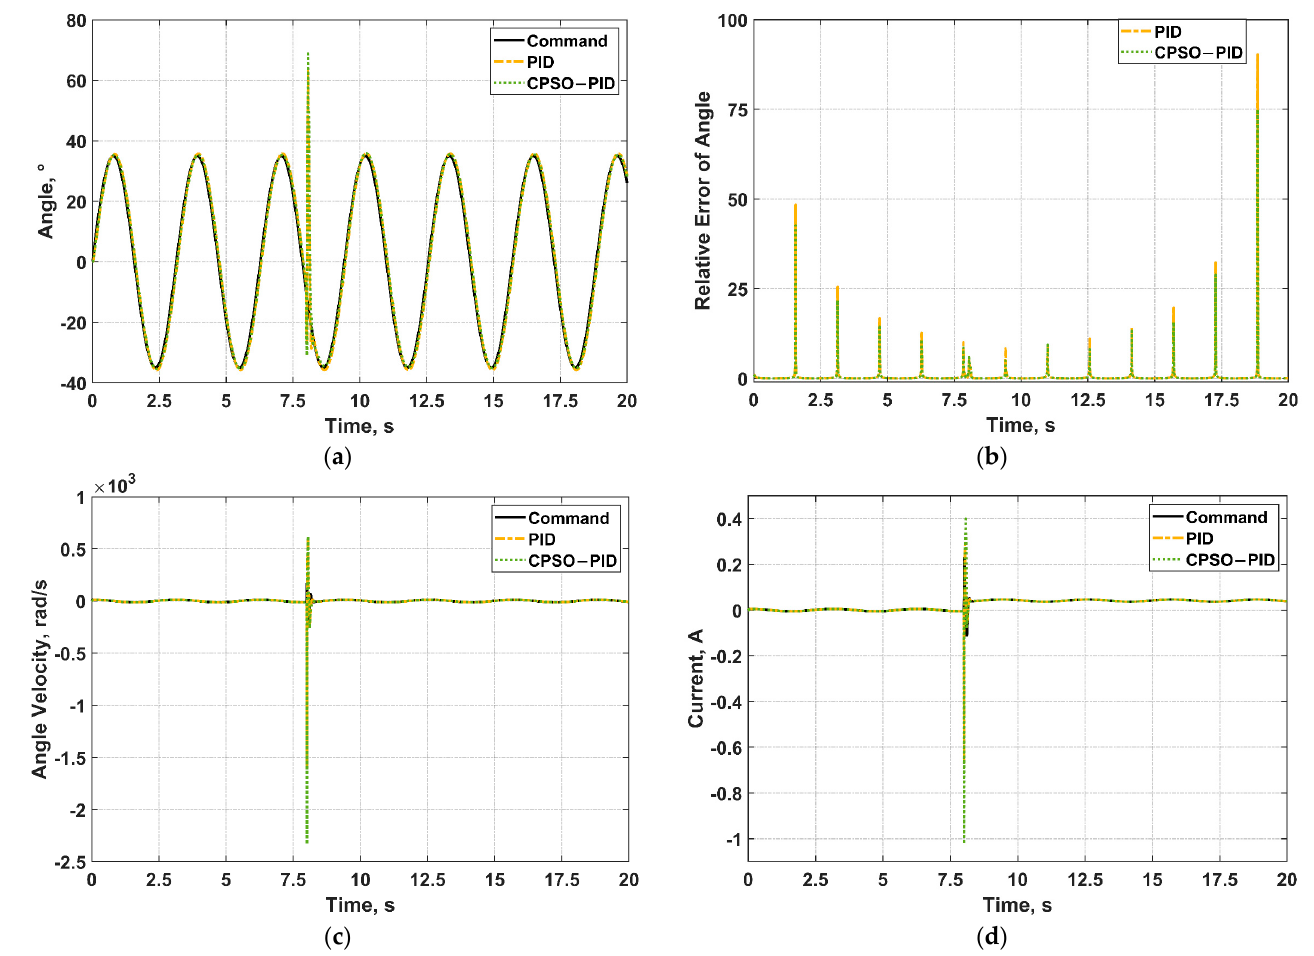
Figure 12. The simulation result when the angle command input signal is a sine wave with frequency of 2 rad/s adding a step load at t = 8 s. ( a ) Angle control; ( b ) Relative error of angle; ( c ) Angle velocity control; ( d ) Current control.